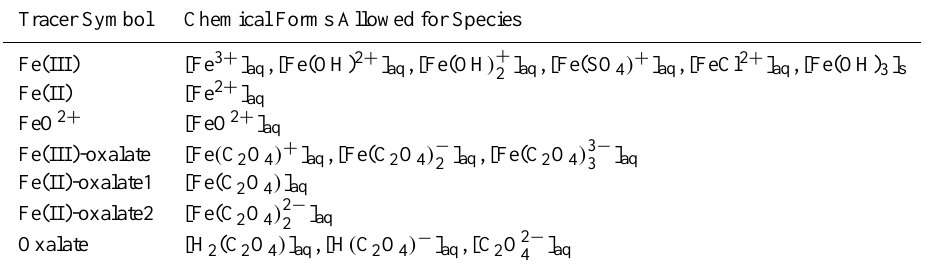
Table 1. Tracers implemented into GEOS-Chem/Fe d and chemical forms allowed for each species. Tracer